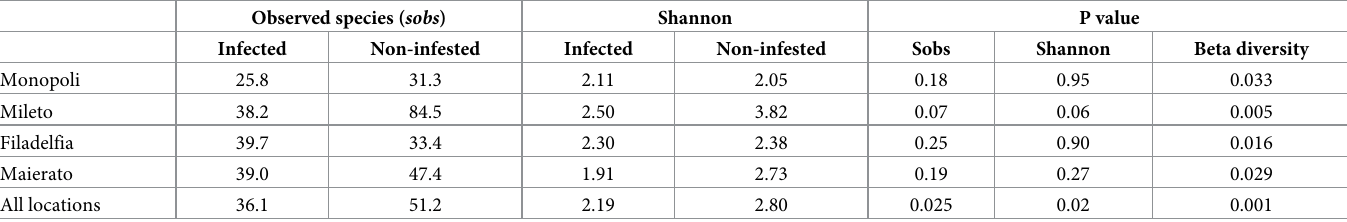
Table 4. Comparison of alpha and beta diversity in infested and non-infested olive drupes collected in Monopoli, Mileto, Filadelfia, or Maierato, according to Shan- non and observed species ( sobs ) indexes. Significance was determined according to the nonparametric test ANOSIM for beta diversity and student t-test for Shannon and observed species ( sobs ). P-values were determined using 999 Monte Carlo